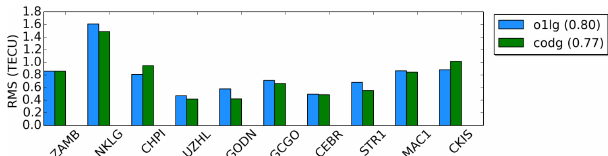
Figure 11. RMS values for the “codg” (green) and “o1lg” (blue) products computed at the 10 receiver stations shown in Fig. 10. The values in parentheses in the legend are the average RMS values over all 10 receiver stations for the entire test period between 1 and 30 September